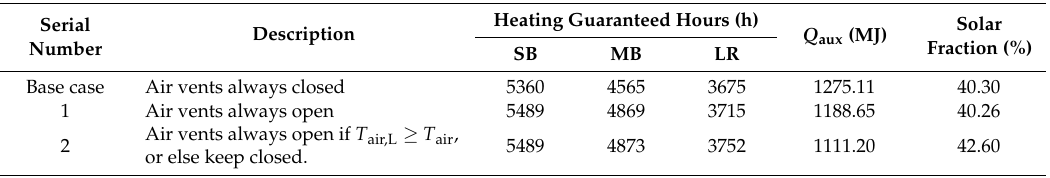
Table 8. Heating effect and system performance evaluation of on/off operation time of the Trombe